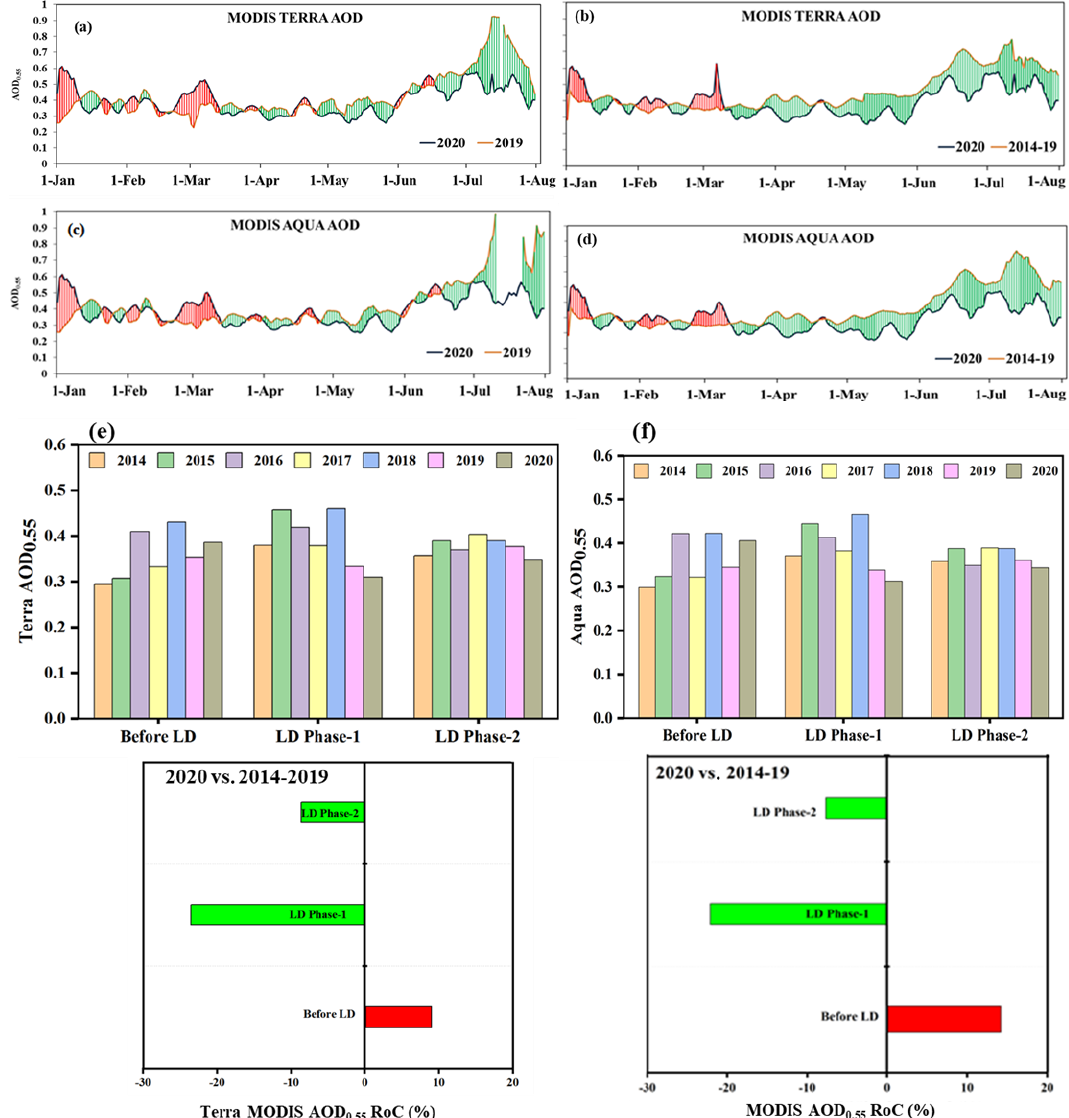
Figure 8. (a) Moving-average time series analysis of AOD 550 measured by Terra MODIS during 2019 and 2020. (b) Terra MODIS short- term climatological mean of AOD 550 (2014–2019) vs. 2020 (c) time series AOD 550 measured by Aqua MODIS during 2019 and 2020. (d) Aqua MODIS short-term climatological mean of AOD 550 (2014–2019) vs. 2020. (e) Variations in Terra MODIS-measured AOD 550 before lockdown and different phases of lockdown and respective RoC. (f) Variations in Aqua MODIS-measured AOD 550 before lockdown and different phases of lockdown and respective